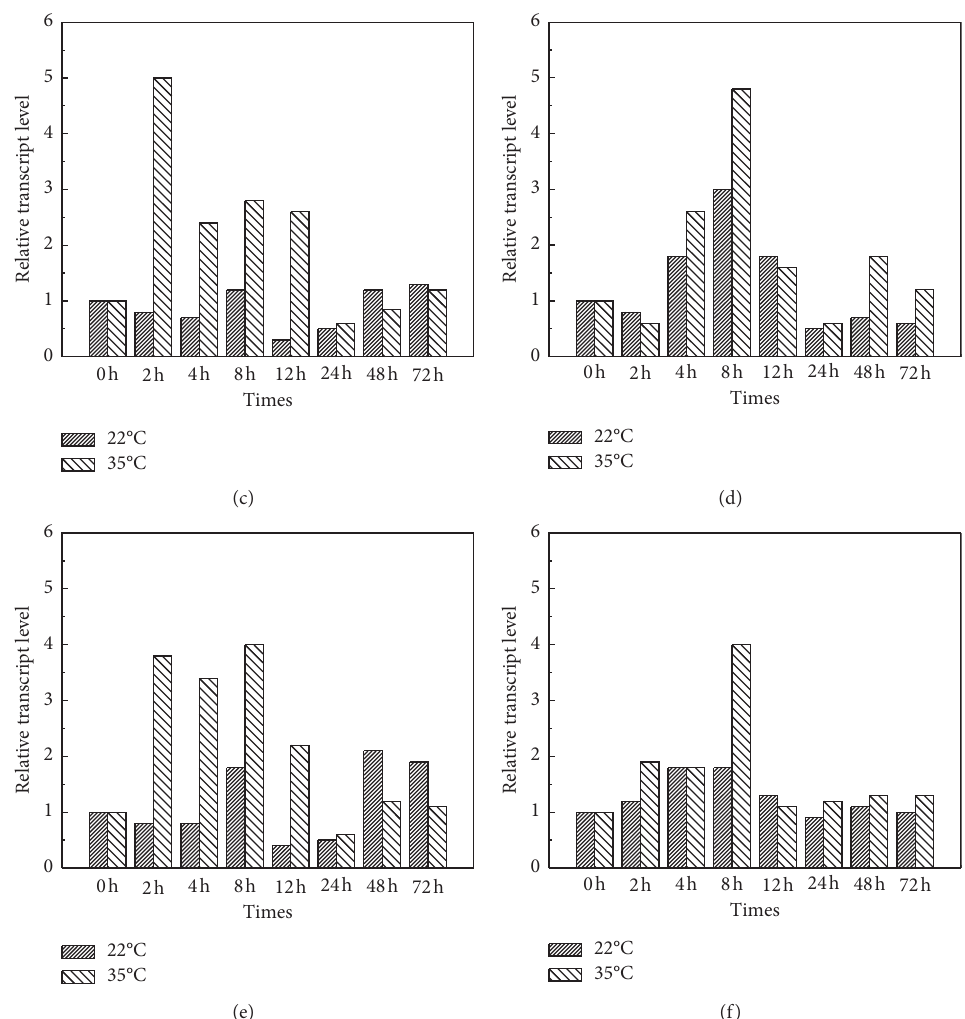
Figure 6: Effect of high temperature stress on SOD gene expression in potato. (a) SOD1. (b) Fe-SOD1. (c) Fe-SOD2. (d) Fe-SOD3. (e) Fe- SOD4. (f)